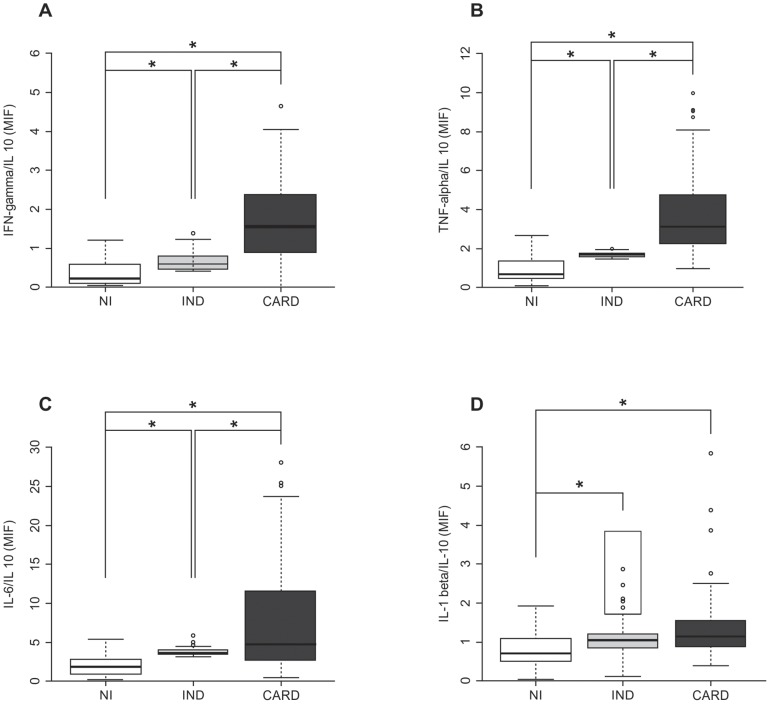
Ratios of plasma cytokines from patients with distinct forms of Chagas disease.The analysis of plasma levels was performed as described in the material and methods section. The groups evaluated were: NI (n = 24, white box), IND (n = 82, light gray box), and CARD (n = 94, dark gray box). The results are expressed by mean intensity of fluorescence (MIF). A) Ratios between IFN-γ and IL-10 levels in NI, IND, and CARD groups. B) Ratios between TNF-α and IL10 levels in NI, IND, and CARD groups. C) Ratios between IL-6 and IL-10 levels in NI, IND, and CARD groups. D) Ratios between IL-1β and IL-10 levels in NI, IND, and CARD groups. This analysis was employed to determine the balance between high-inflammatory or high-regulatory cytokines and to represent the predominant cytokine profile. Significant differences (P-value<0.05) in the charts are identified by connecting lines and the symbol (*) for comparisons between the groups.